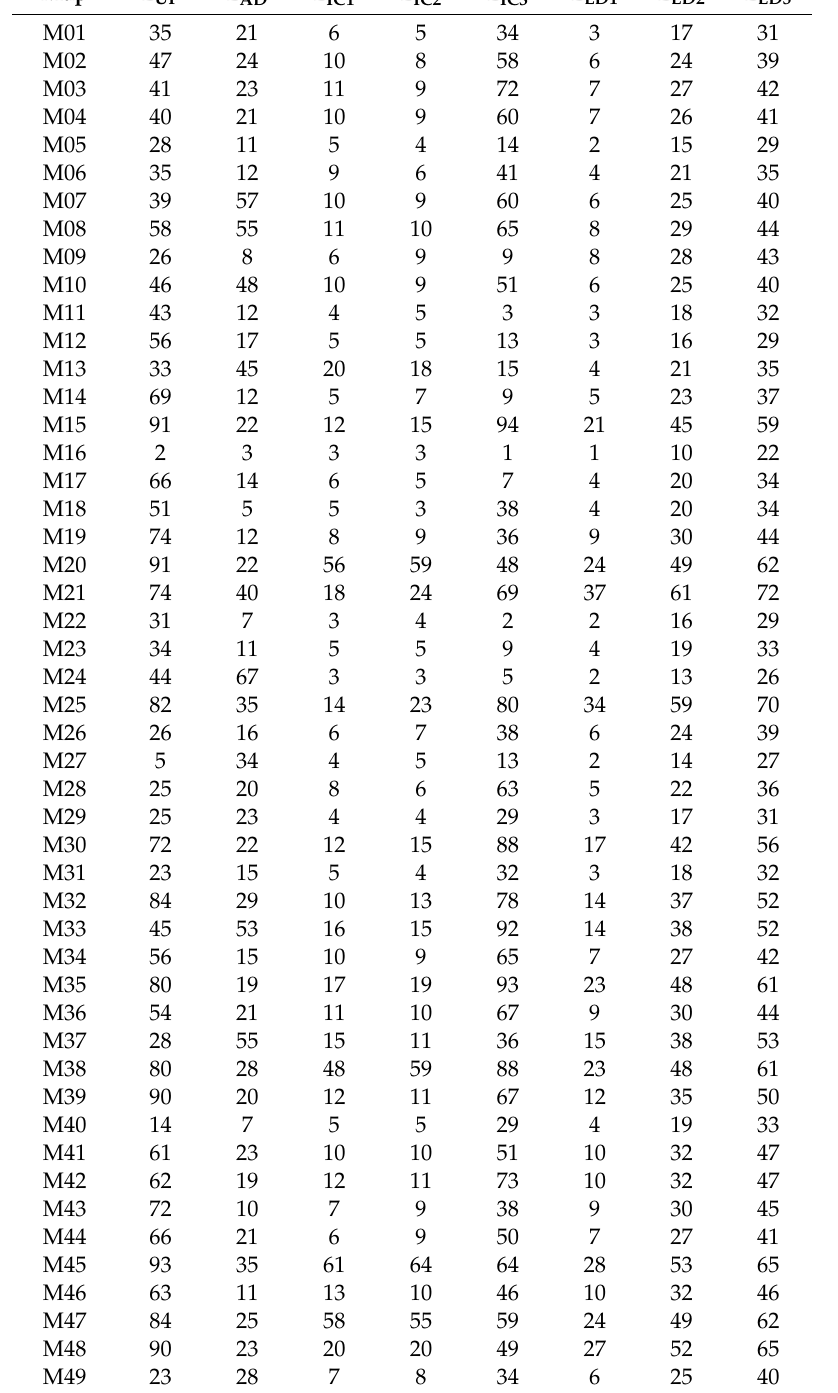
Table 1. User perceived and measured map-load values of maps from the Ref-Set